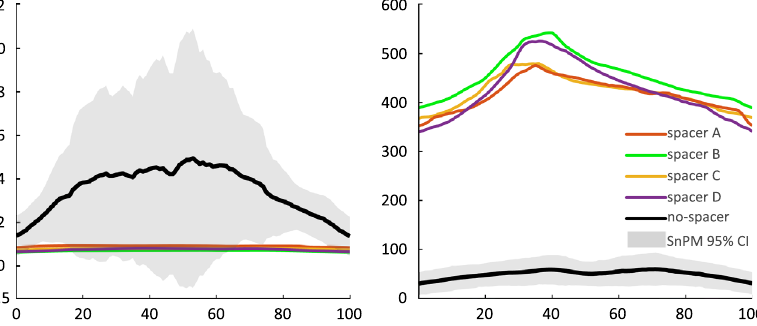
Figure 4. Mean stress and loaded area. Time series representing a) mean stress and b) loaded area (± 95% confidence interval of the no-spacer condition calculated using statistical non-parametric mapping (SnPM)).